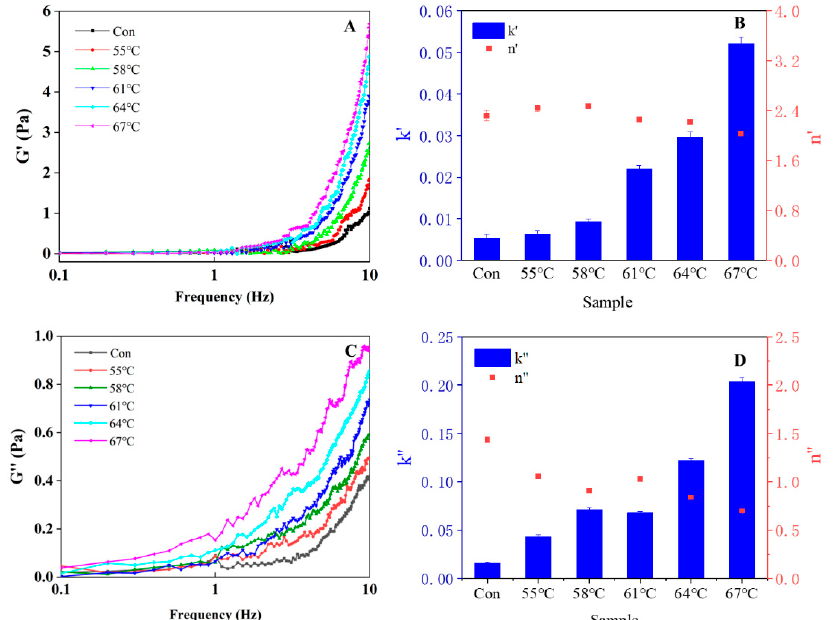
Figure 7. The effect of different heating treatment conditions on the frequency scanning diagram of LWE. ( A ): the storage modulus; ( B ): The Ostwald–de Waele model of the storage modulus; ( C ):